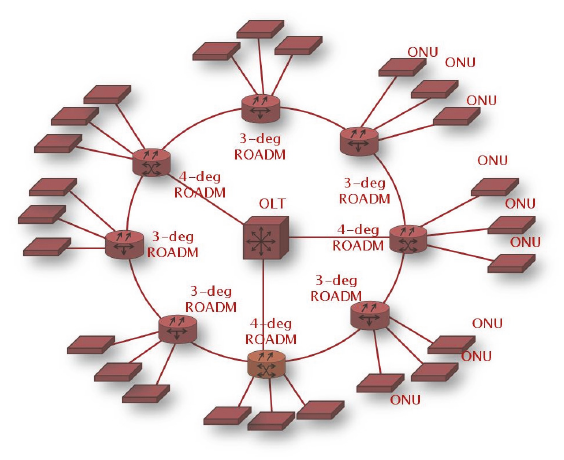
Figure 1: Star-in-ring topology of the proposed SDN-like Innovative Metro-Access Optical Network (SIMON) architecture.